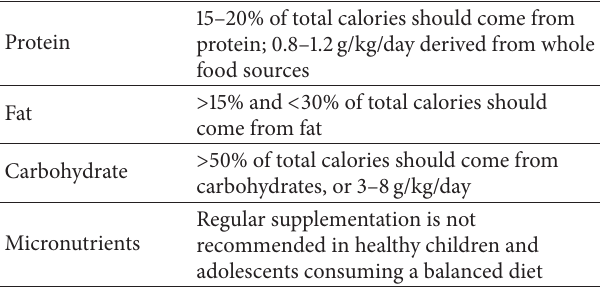
Table 2: General nutrition recommendations for maintaining health.